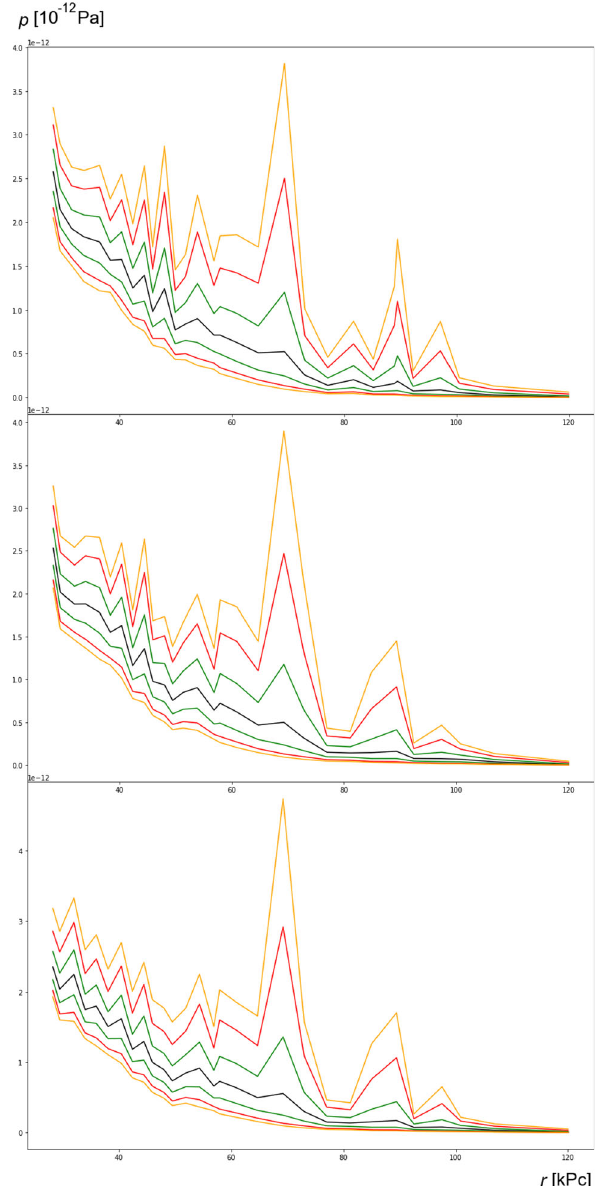
Fig. 8 Median (black line) and lower and upper bounds of 68% (green lines), 95% (red lines) and 99% (orange lines) confidence intervals of p − p 0 − v( r 0 ) 4 for three combinations of distance of Sun from 8 π Gr 2 0 the galactic center and Sun orbital velocity around the galactic center: = 8 . 0 kpc, v = 200 km/s) (top), ( R = 8 . 3 kpc, v = 244 km/s) ( R 0 0 0 0 (middle) and ( R 0 = 8 . 5 kpc, v 0 = 220 km/s) (bottom)